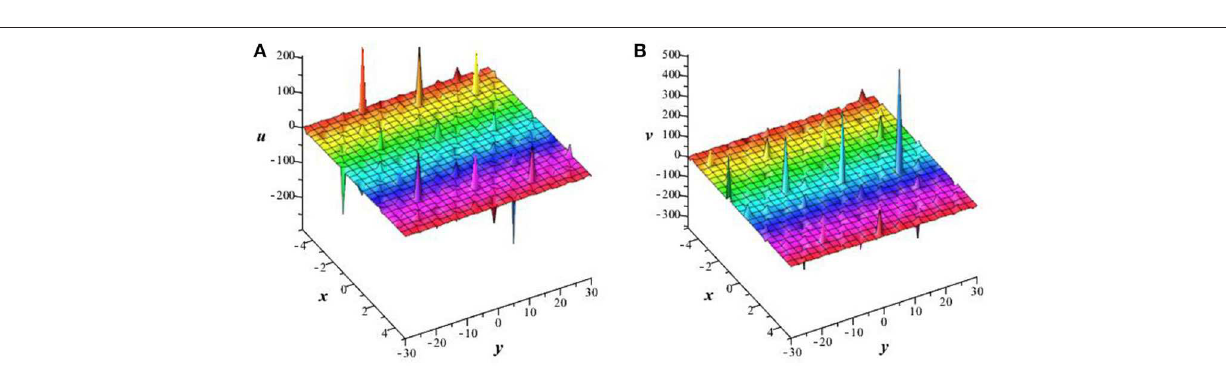
B 1 k 2 k 3 µ χ 1, C 1 2, C 2 1, λ 1, B 0 1 at t 5. (A) Perspective view of the solution u . (B) = = = = = = = = = = =